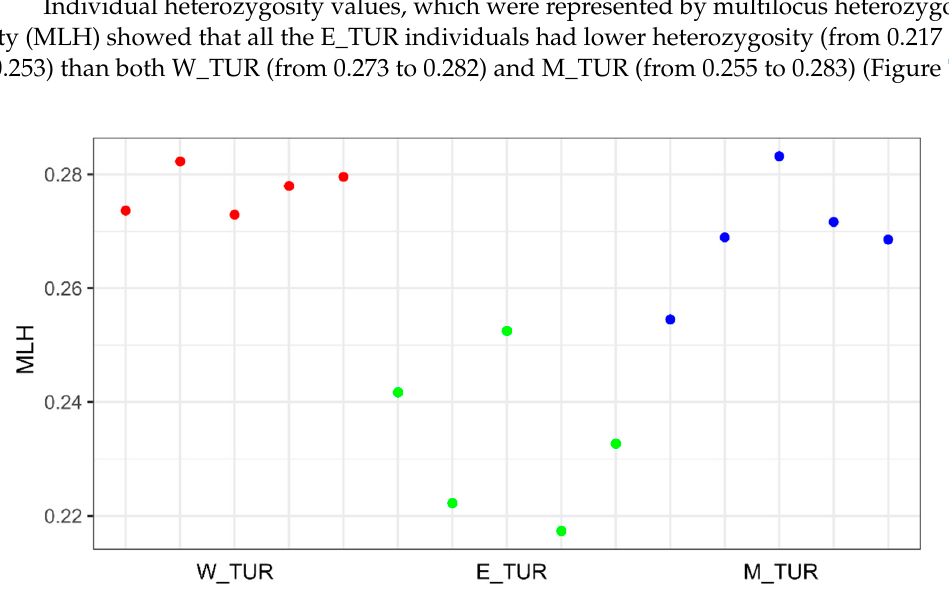
Figure 7. Individual multilocus heterozygosity (MLH) in the groups of Caucasian tur ( Capra caucasica ).